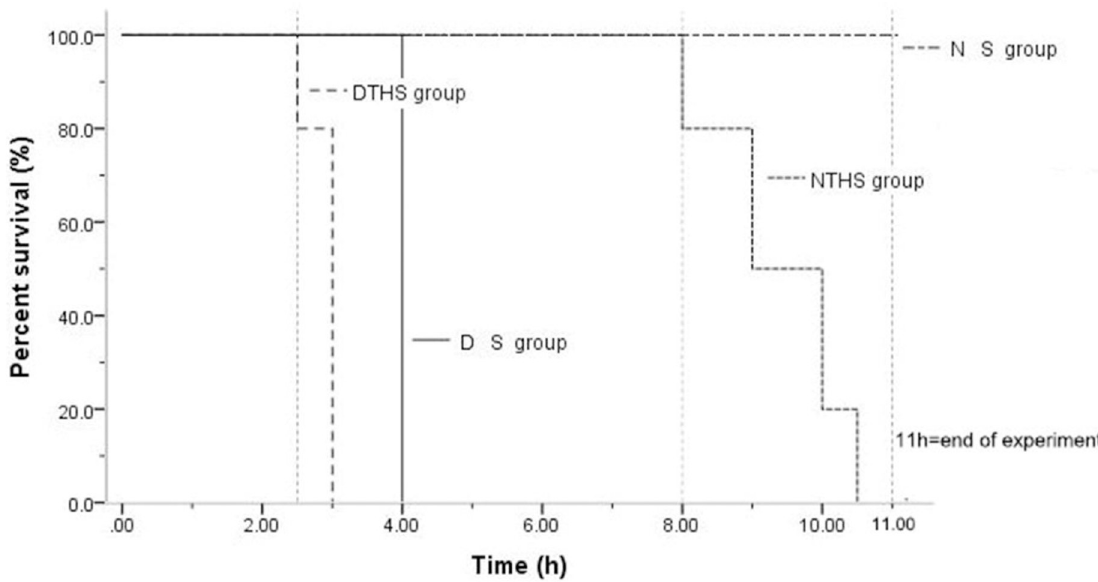
Fig 2. B: Survival curves in the NS, NTHS, DS, and DTHS groups. Dotted and broken line, NS group; dotted line, NTHS group; straight line, DS group; broken line, DTHS group.